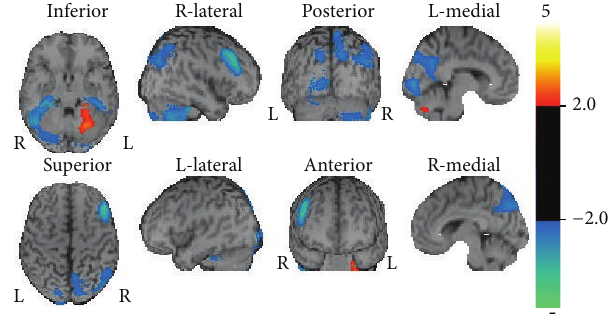
Figure 2: Single-photon emission computed tomography images of the brain using technetium-99m-ethyl cysteinate dimer, analyzed with the 𝑍 -score imaging system (eZIS), in Case 2 obtained on Day 13, showing multifocal hypoperfusion mainly in the cortex of the parietal lobe, the precuneus, the right cerebellum, and the posterior cingulate